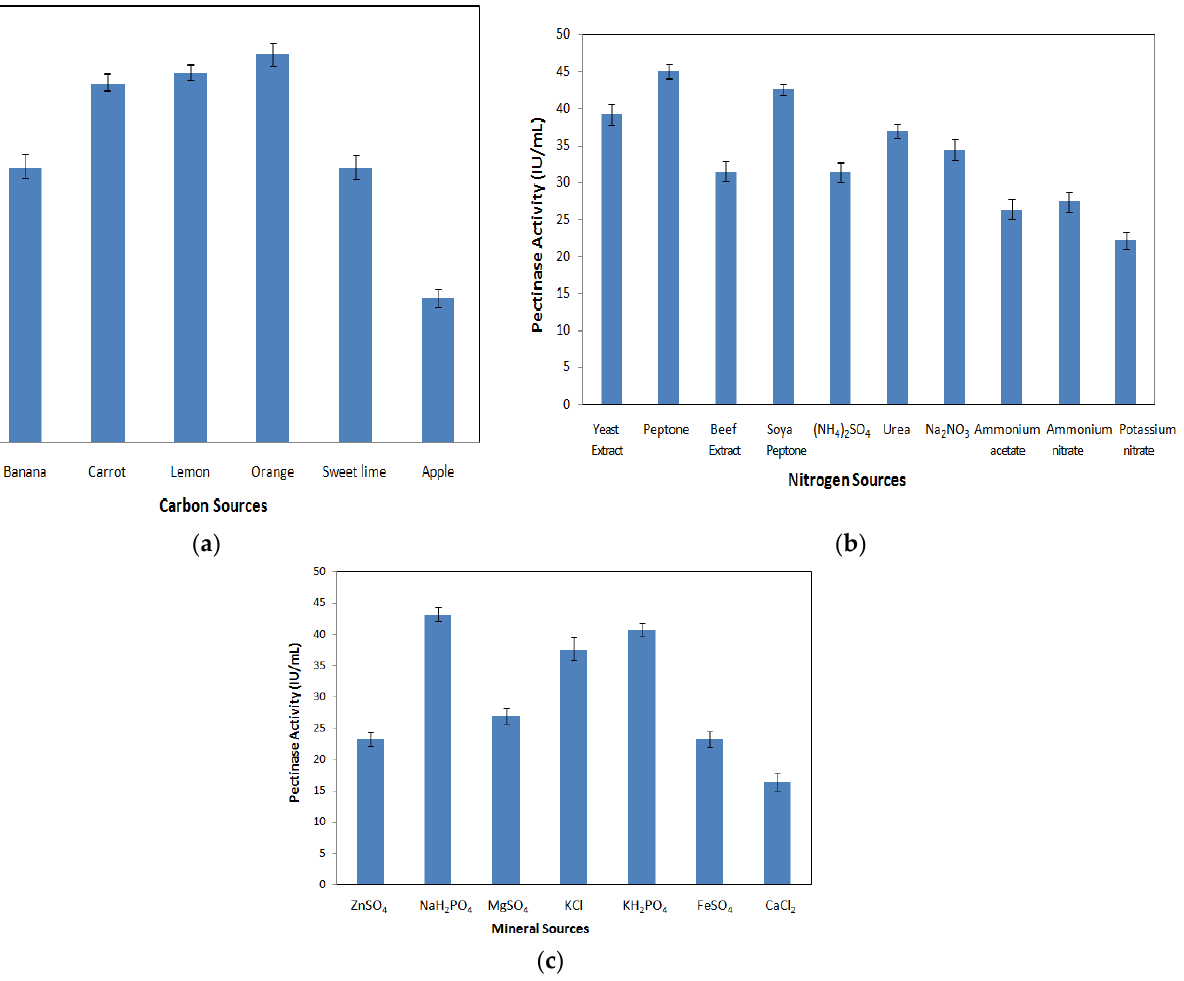
Figure 4. Pectinase activity of Aspergillus cervinus ARS2 for different ( a ) carbon sources, ( b ) nitrogen sources, and ( c ) mineral sources.